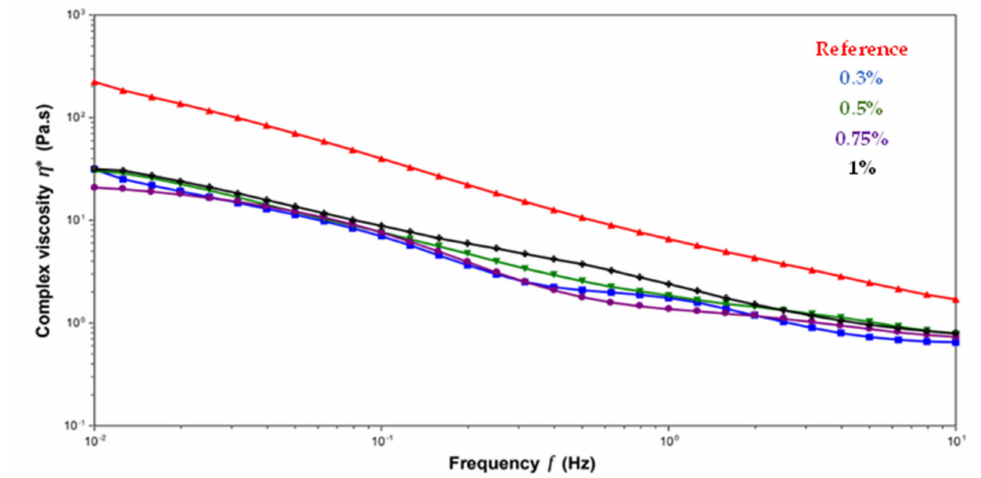
Figure 5. Complex viscosity of PGE with different loads of WS 2 -TO at room